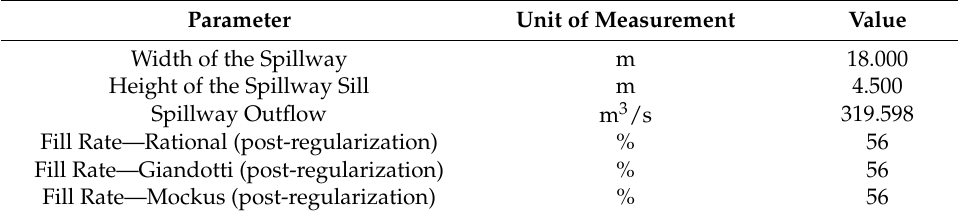
Table 7. Application of the Cipolletti spillway.